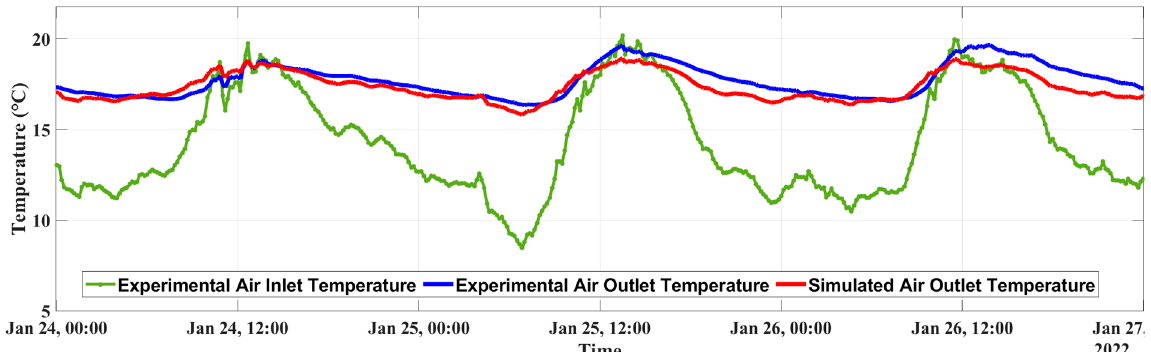
Figure 17. Experimental and simulation results of the deployed EAHE system (heating behavior from 24 to 26 January 2022).